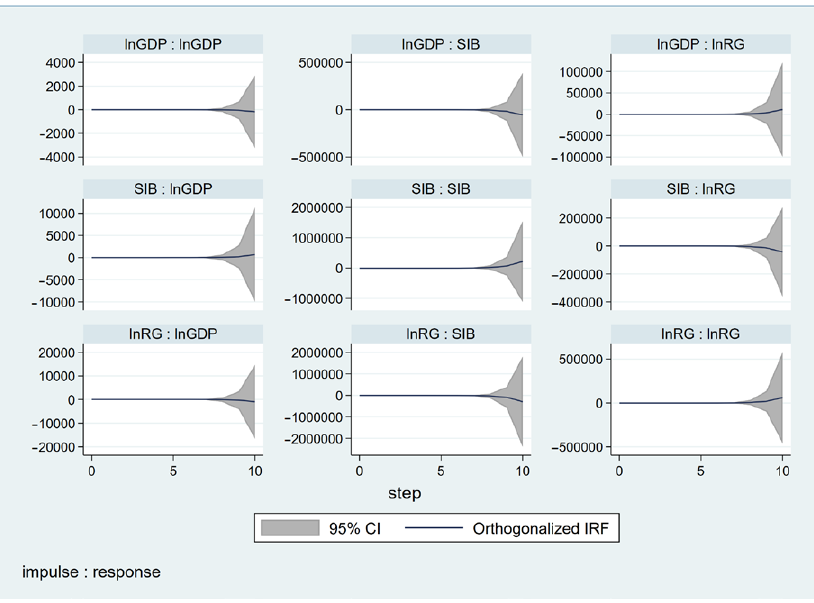
Figure 1. Estimate impulse-response functions (source: author’s calculation STATA program, 2021) Estimation of impulse-response function (see Figure 1) confirmed that SIB reduces